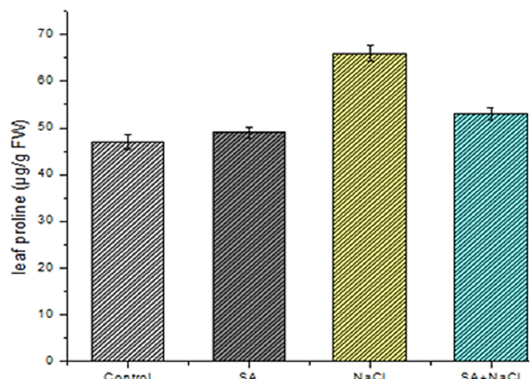
Figure 7. Leaf proline content: individual and combined effect of salinity and SA on leaf proline content. X axis -treatment group; Y axis - concentration of leaf proline (µg/FW) Values are expressed as mean ± SD, n=3 in each group.